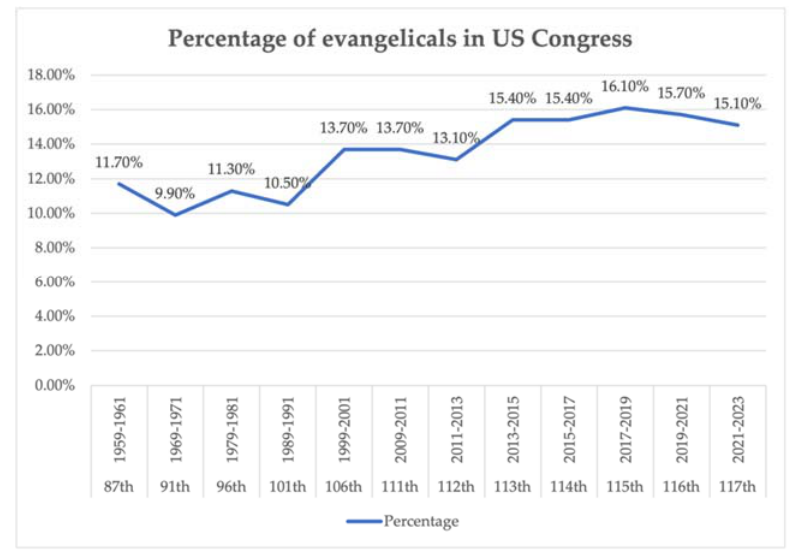
Figure 1. Percentage of evangelicals in the US Congress (1959–2023). Source: Pew Research Center, https://www.pewforum.org/2021/01/04/faith ‐ on ‐ the ‐ hill ‐ 2021/ (accessed on 6 August 2021).